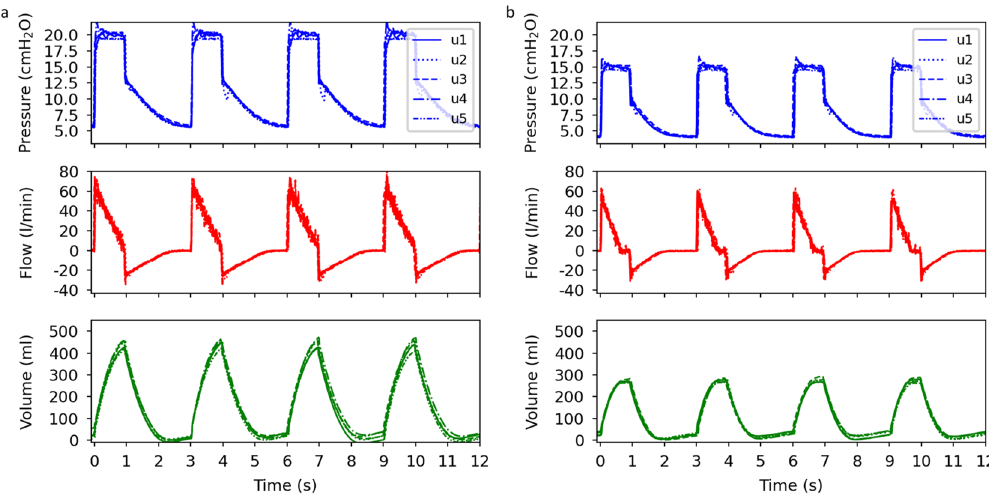
Figure 1. Plots of the airway pressure, flow, ventilation volume as a function of time for the P IP values ( a ) 20 cmH 2 O and ( b ) 15 cmH 2 O. Each curve corresponds to a ventilator with a different CPAP machine model (referred to as u1, u2, u3, u4 and u5). All measurements are performed on an artificial lung. Respiratory rate: 20 bpm, I:E ratio: